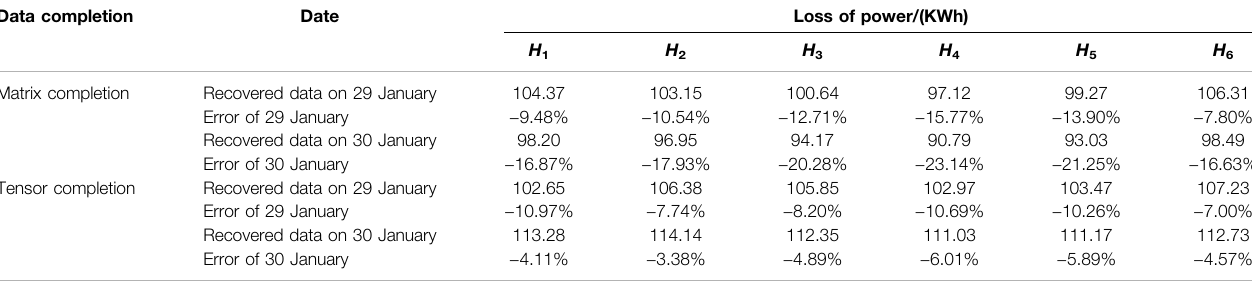
TABLE 7 | Calculated loss for each recovered anomaly user.